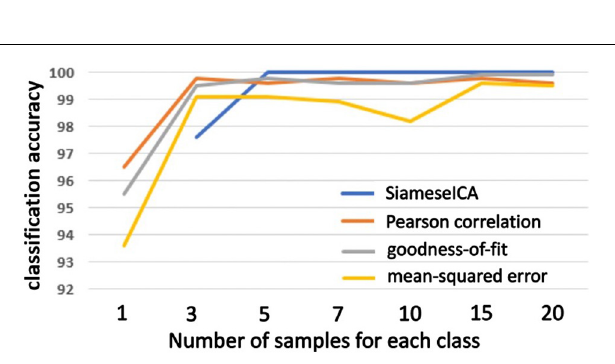
FIGURE 8 | Plots of classification accuracy on the BeijingFCP dataset with different number of examples trained for the proposed SiameseICA model and majority voting over different number of reference samples for Pearson correlation, goodness-of-fit and mean-squared error